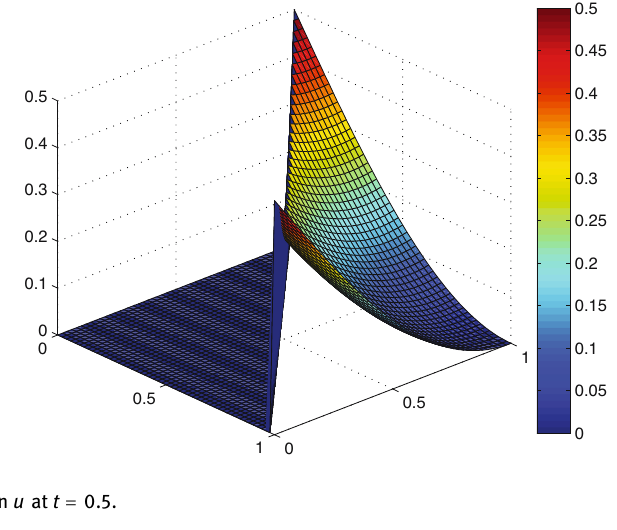
Figure 1: The exact solution u at = t 0.5 .